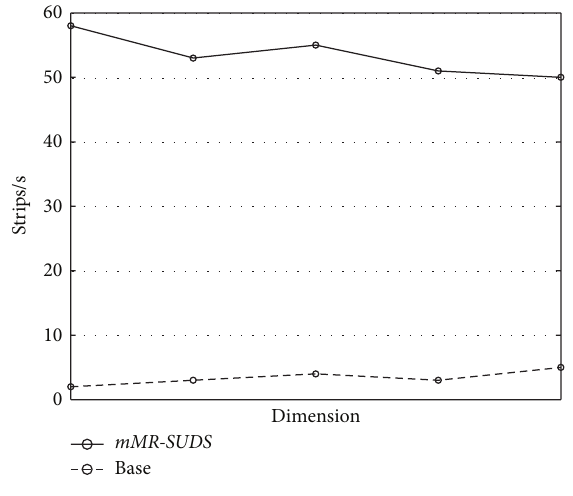
Figure 12: The effect of the dimension of data.